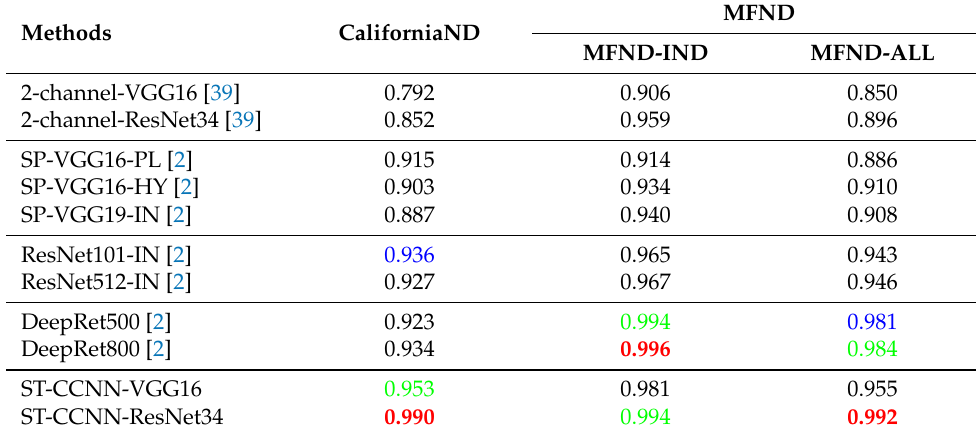
Table 2. Area under the receiver operating characteristic (AUROC) comparison on single modality datasets of ST-CCNN and other state-of-the-art